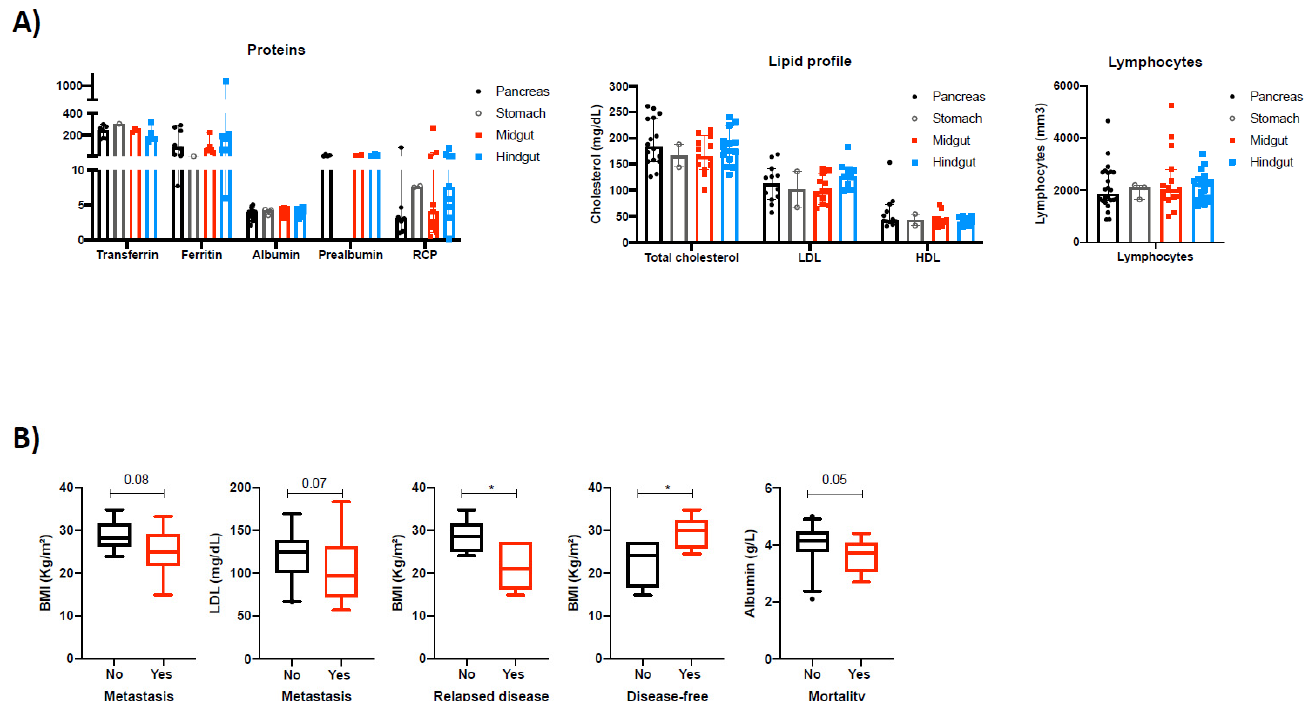
Figure 1. ( A ) Biochemical parameters for assessing nutritional status in patients with NENs according to the primary tumor site. ( B ) clinical associations between nutritional parameters and clinical outcome in NEN patients. *: p <